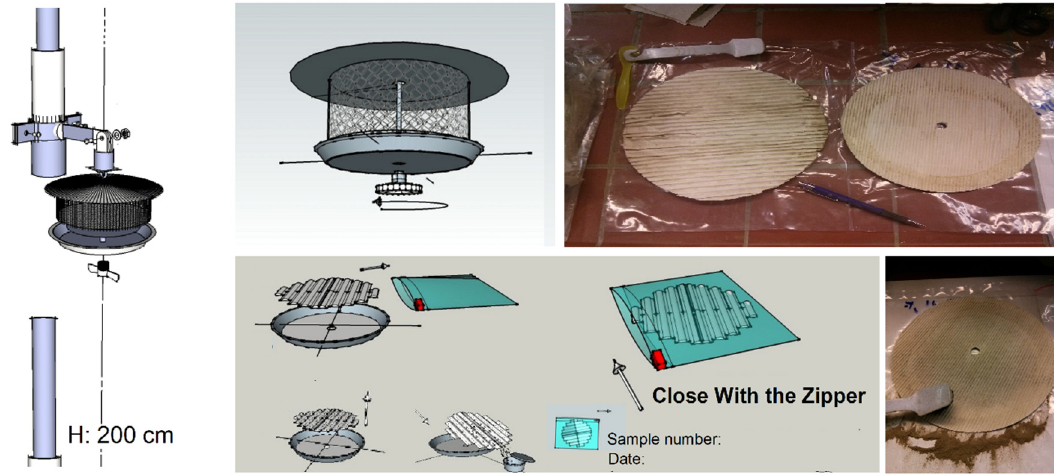
Figure 2. Installation and sampling technique; modified photos by courtesy of [28].